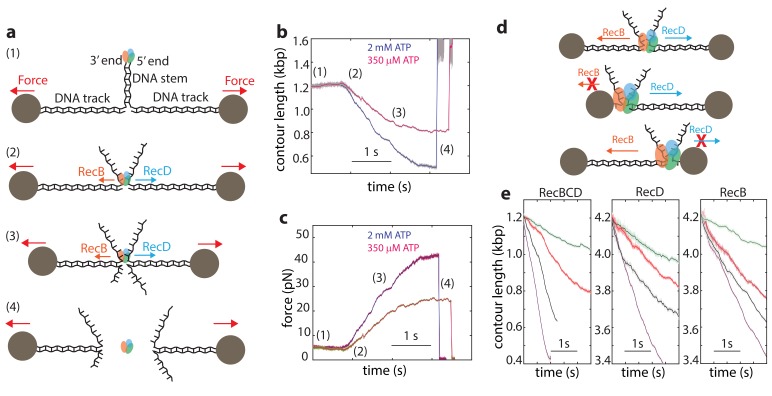
Monitoring RecBCD and its individual subunits ‘in complex’.(a) Schematic representation of the experimental optical tweezers setup. From top to bottom: RecBCD binds to, and translocates on a DNA stem connected to optically trapped beads through DNA ‘tracks’. Upon reaching the fork, the helicase subunits translocate in different directions due to their opposing polarities, shortening the tether length and increasing the tension on it. The force increases up to a point where RecBCD dissociates from the construct. (b) Two representative contour-time traces, for [ATP] = 2 mM (blue) and [ATP] = 350 uM (purple). Raw data is shown in grey, filtered data (fc = 250 Hz) is shown in blue and purple. (c) The corresponding force-time trace. Raw data is shown in grey; filtered data is shown in blue. (d) Symmetric molecular construct (top, 600 bp and 600 bp) to probe RecBCD and asymmetric constructs (middle, 35 nt and 4200 bp, and bottom, 4200 bp and 35 nt) to probe RecB and RecD, respectively. (e) Representative traces probing both translocases (left), RecD (middle) and RecD (right), at different ATP concentrations (purple, 2 mM; gray, 1 mM; red, 100 μM; green, 20 μM). Raw data is shown in light colors, filtered data (fc = 250 Hz) is shown in dark colors.